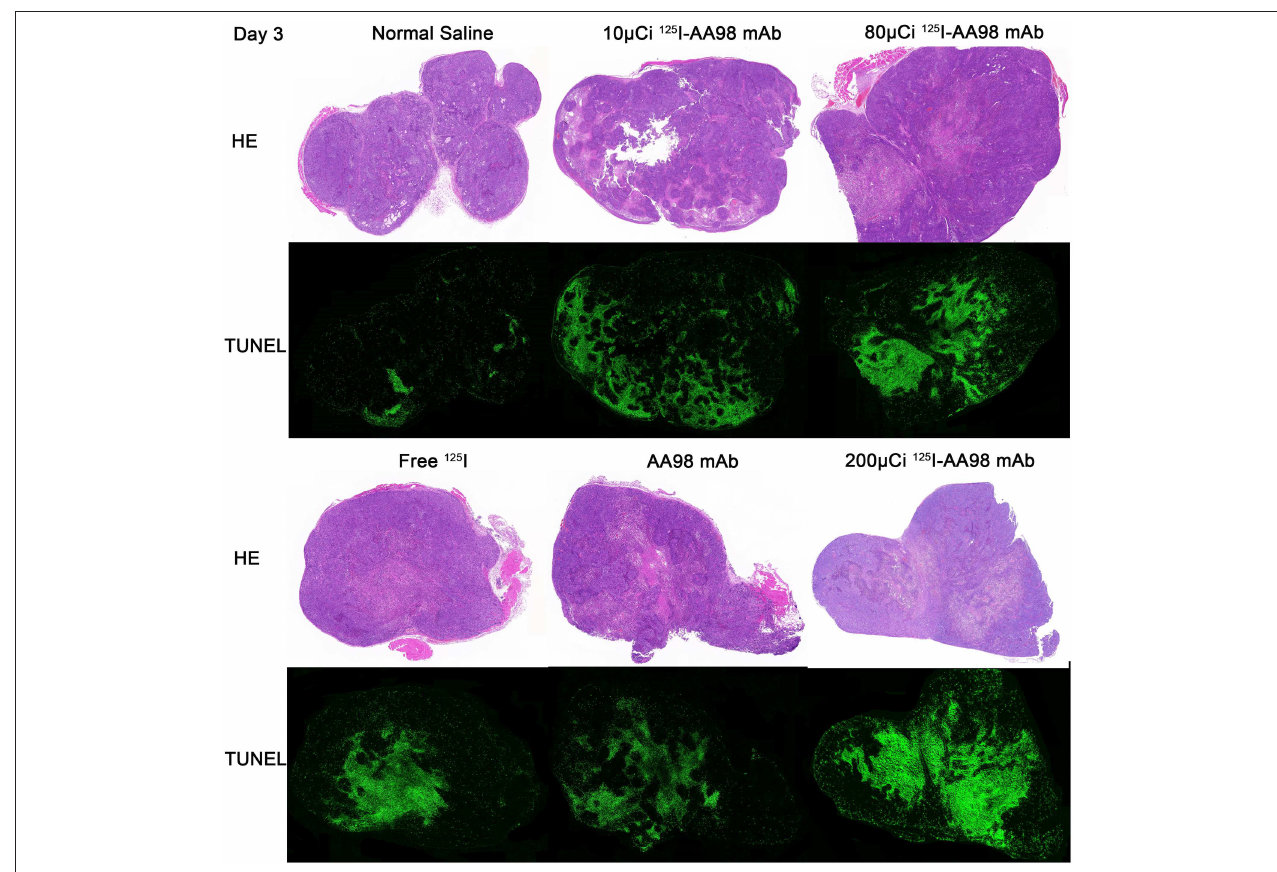
FIGURE 2 | Photographs of pair-matched HE staining and TUNEL fluorescence staining 3 days after intratumoral injection in each